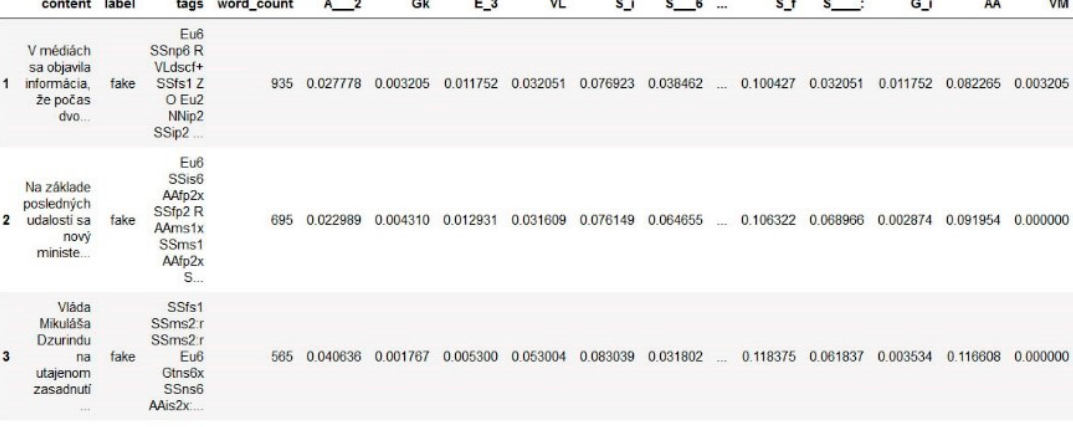
Figure 4. Preview of the dataset (Approach 2) created after identifying morphological tags and calculating the number of words in each article.